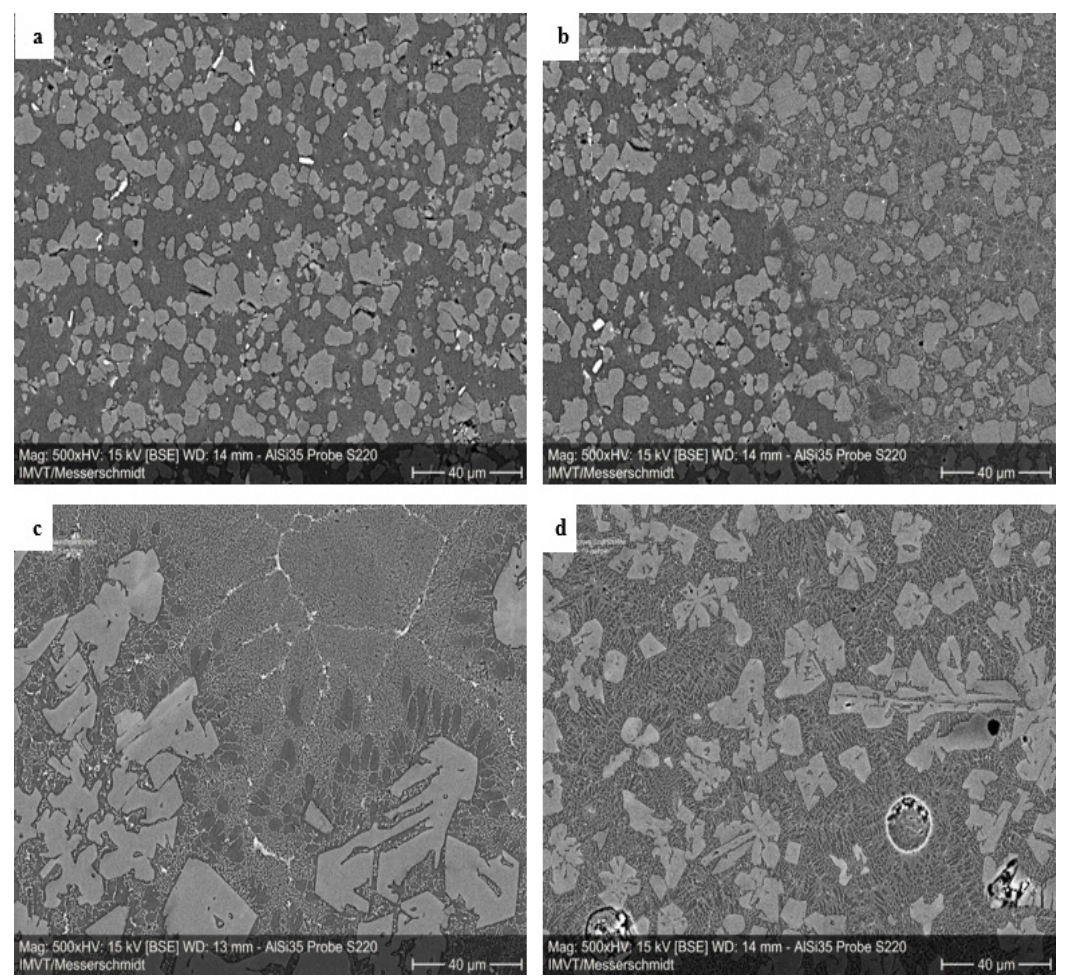
Figure 4. S220: ( a ) Base material; ( b ) Transition of weld seam to base material; ( c ) Center of the weld seam for v = 0.5 m/min; ( d ) Center of the weld seam for v = 10 m/min.